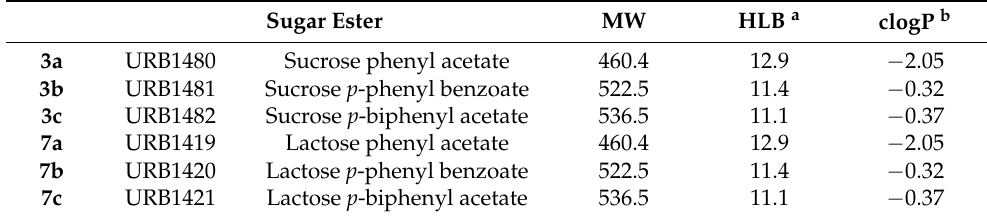
Table 1. Calculated physicochemical properties of the sugar-based ester